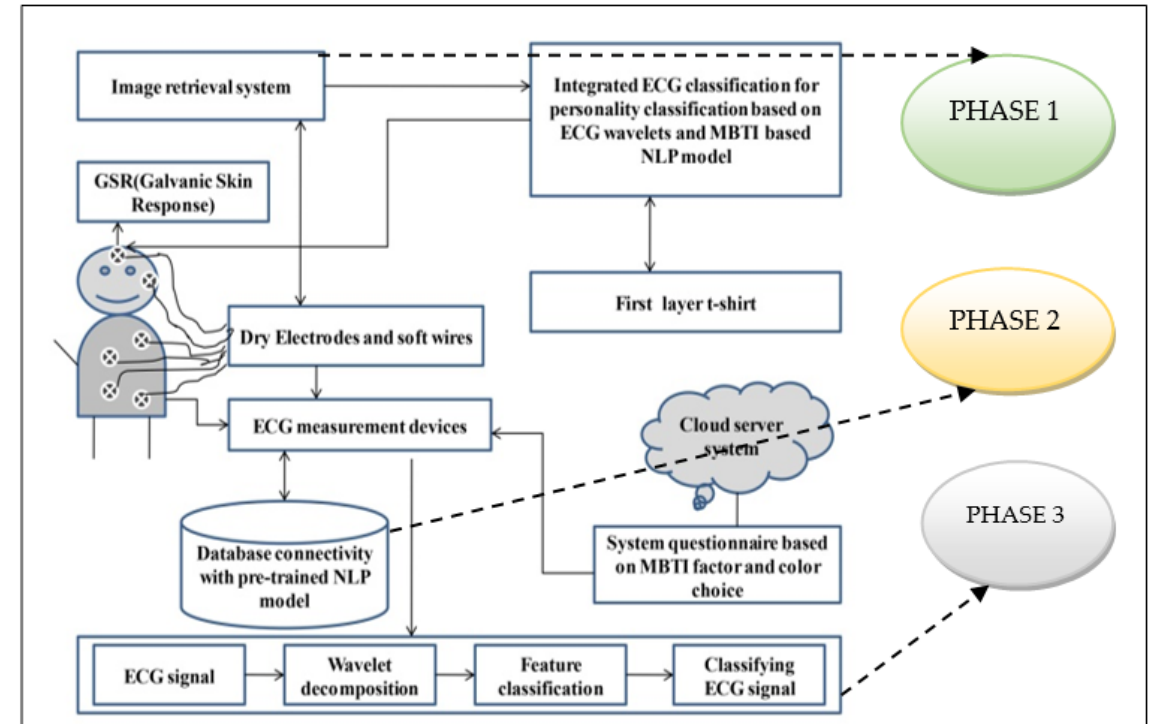
Figure 1. Proposed framework for content-based recommendation model.